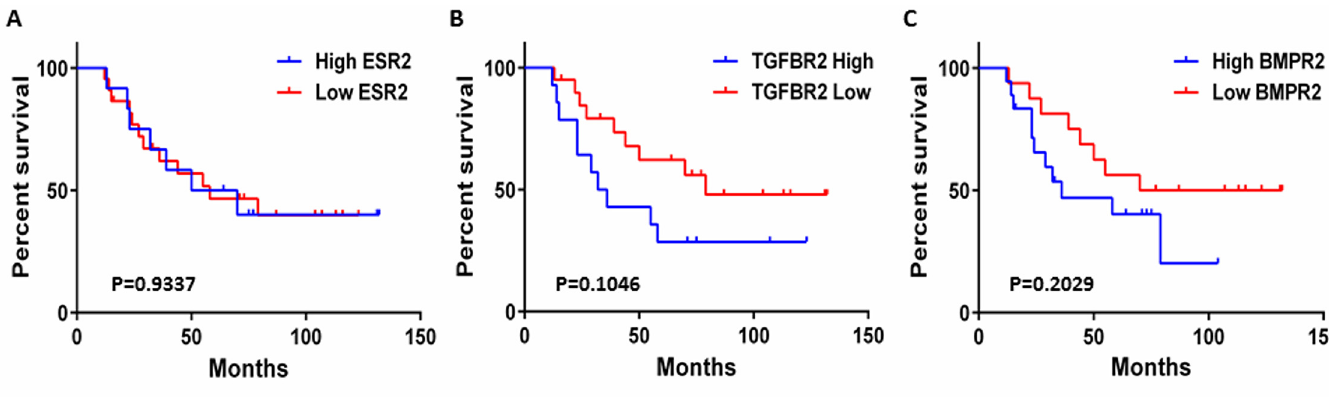
Fig 6. In silico analyses using the Oncomine platform showed that expression of the ESR2 gene in the breast tumour microenvironment does not correlate with patient outcome (p = 0.9337) (A). Expression of TGFBR2 (B) and BMPR2 (C) showed a trend towards significance (p = 0.1046 and p = 0.2029) suggesting that high expression levels of these genes are associated with lower rates of patient